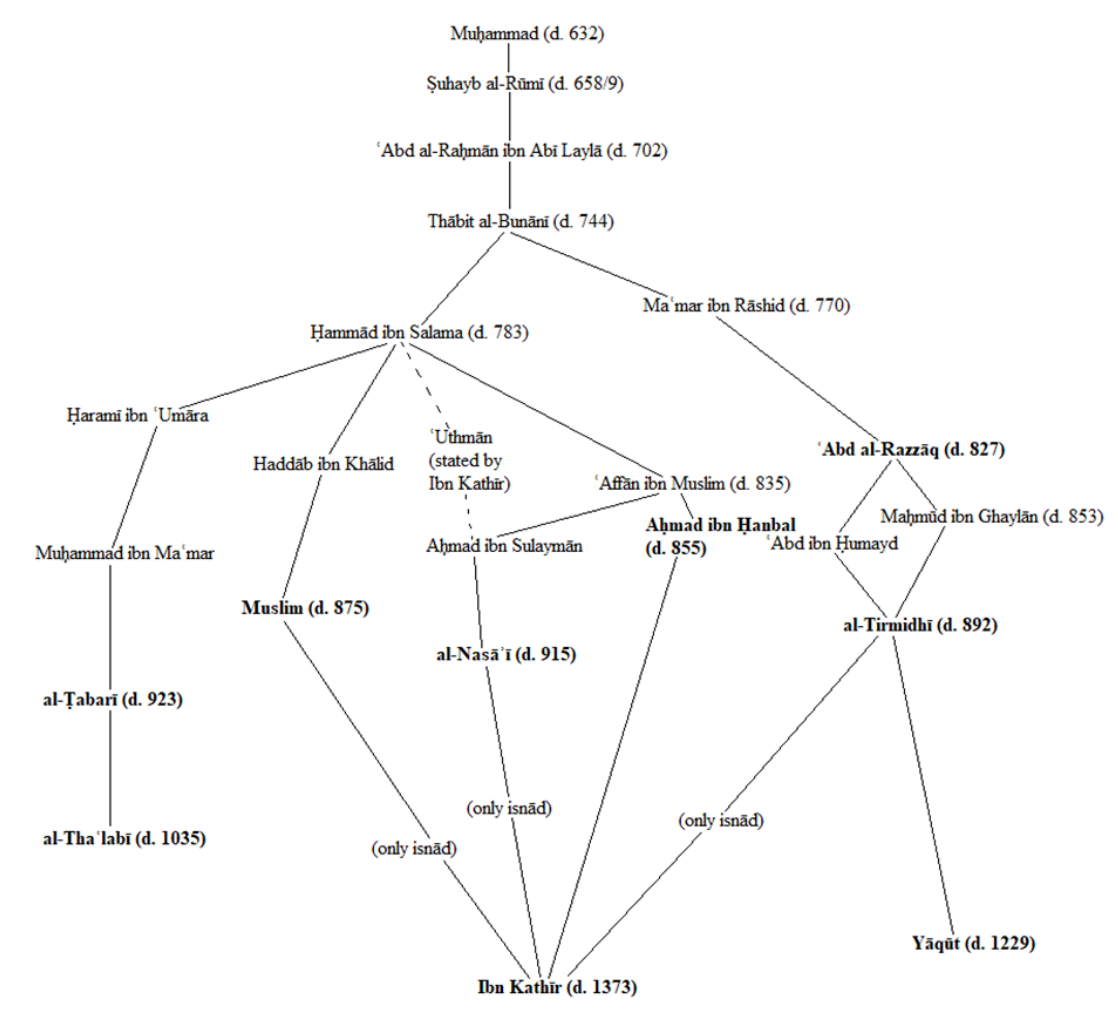
Figure 4 The Ṣuhayb recension of the tradition of the boy and the